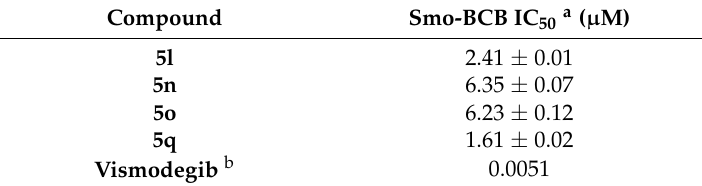
Table 2. In vitro inhibition of Smo for selected derivatives.